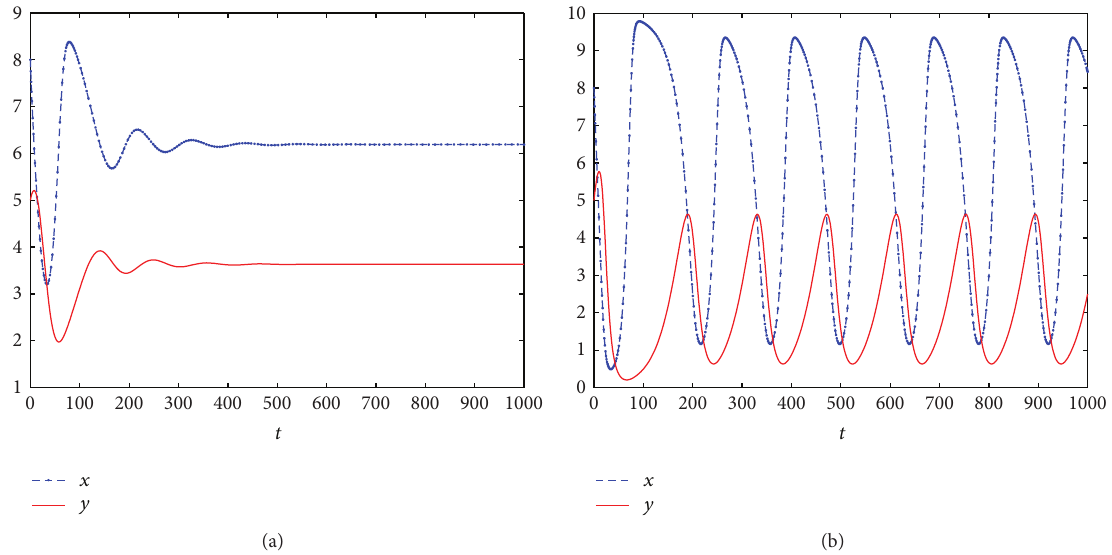
Figure1: Theinfected steady state 𝐸 ∗ of system(1) is asymptotically stable when 𝜀 = 0.3 (a)andunstablewhen 𝜀 = 0.42 (b). Therestparameter values are 𝑟 = 0.1 , 𝐾 = 10 , 𝛽 = 0.2 , 𝑎 = 0.13 , and 𝜃 = 3 , and the initial values are 𝑥 0 = 8 and 𝑦 0 = 5 .